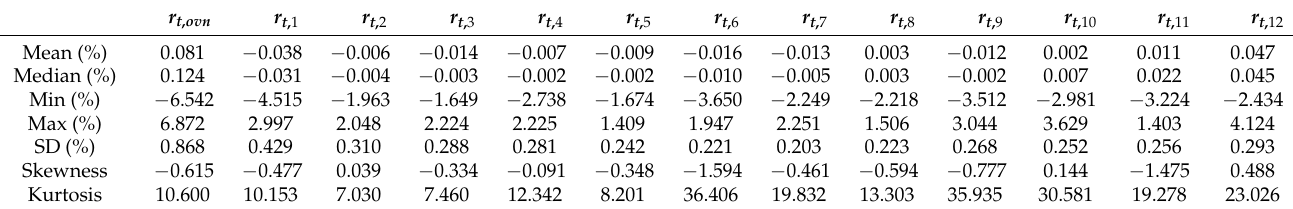
Table 1. Summary statistics of 30 min and overnight returns for the KOSPI Index.